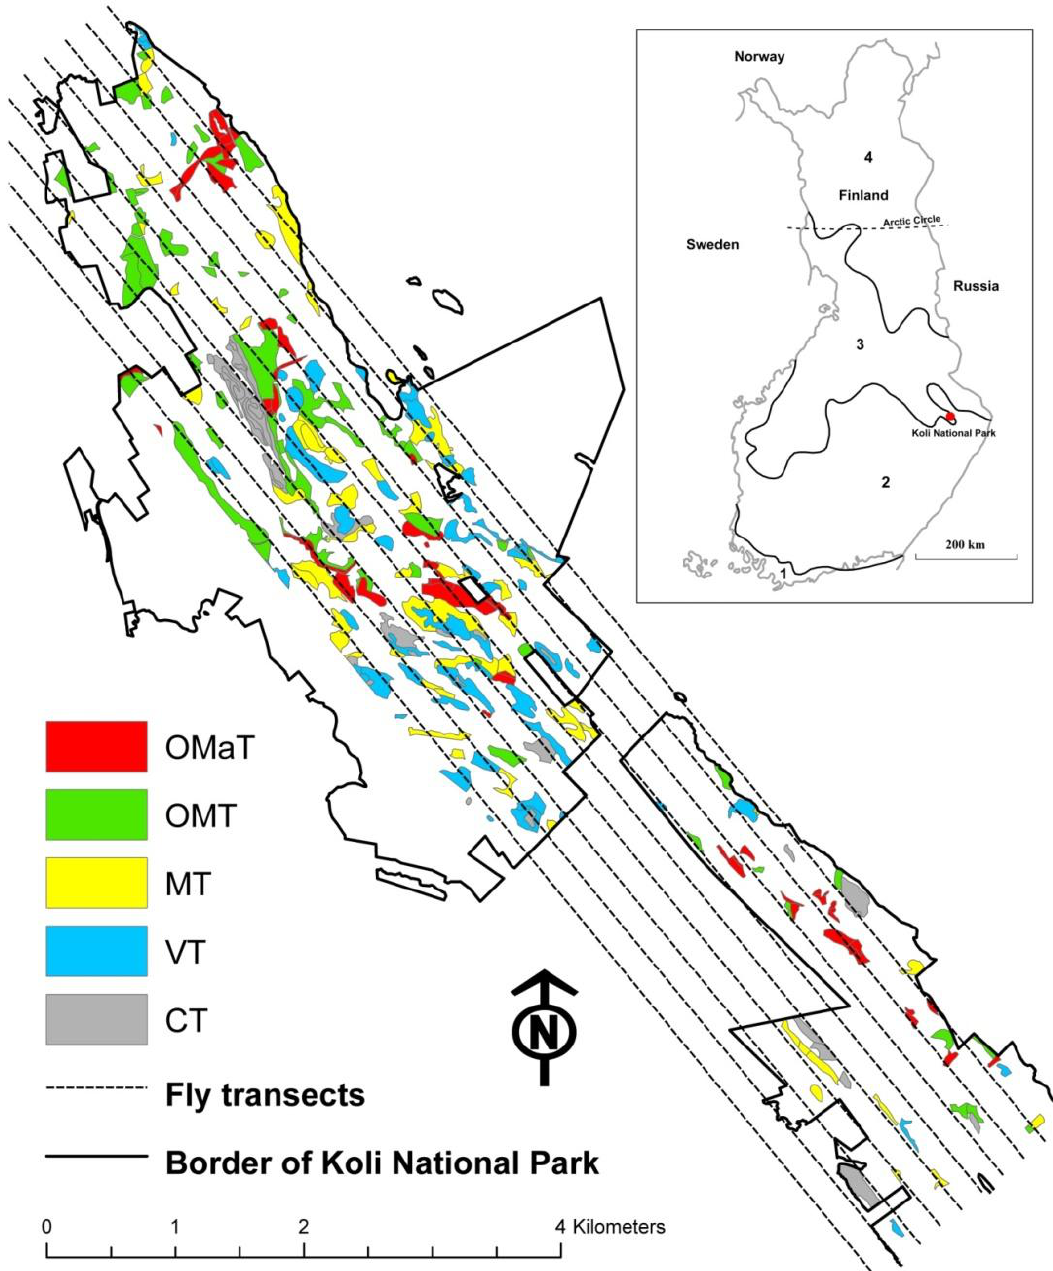
Figure 1. Map of the Koli National Park in eastern Finland, with locations of the stands of the different fertility classes. OMaT denotes very rich, OMT rich, MT medium, VT rather poor and CT poor forest site types [1]. Forest vegetation zones after Kalela [37]: South Finland (1 Hemiboreal and 2 Southern boreal), Pohjanmaa-Kainuu (3 Middle boreal), and Peräpohjola and Metsä-Lappi (4 Northern